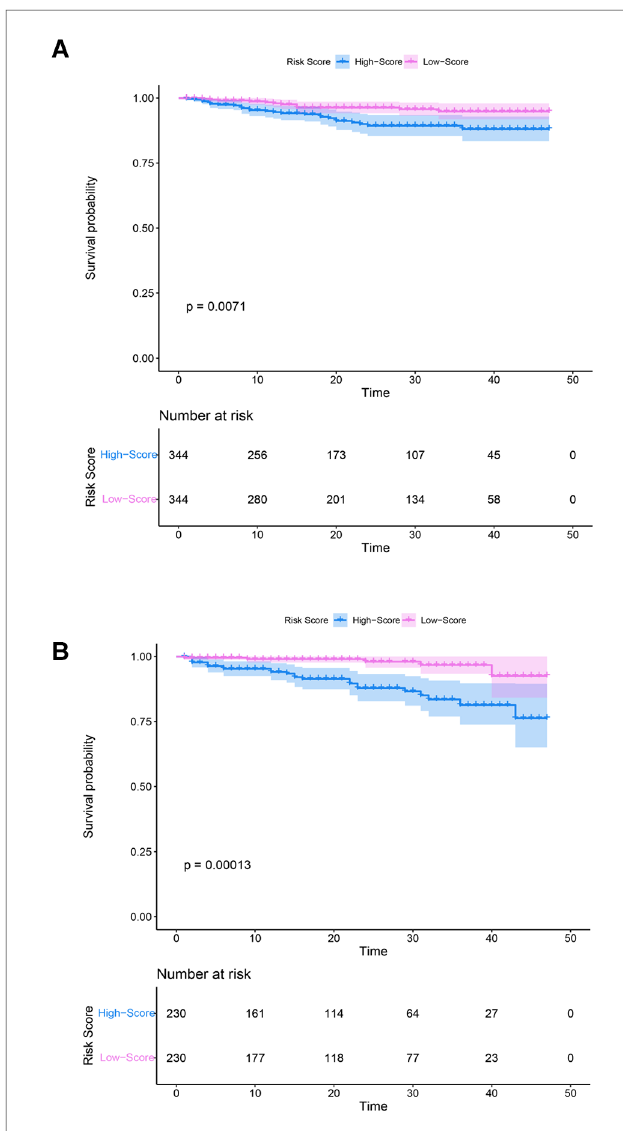
FIGURE 6 Kaplan – Meier curves of the training and testing groups. ( A ) Training group. ( B ) Testing group. Purple and blue represent con fi dence intervals. The horizontal axis represents time (months), and the vertical axis represents survival